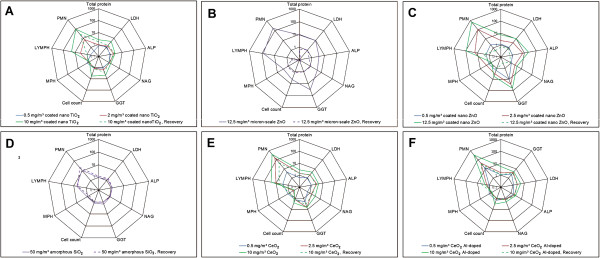
Comparison of changes in BALF. A: coated nano-TiO2. B: micron-scale ZnO; C: coated nano-ZnO; D: SiO2.naked; E: nano-CeO2; F: Al-doped nano-CeO2. Changes are shown as x-fold differences compared to the corresponding control values using a logarithmic scaling.